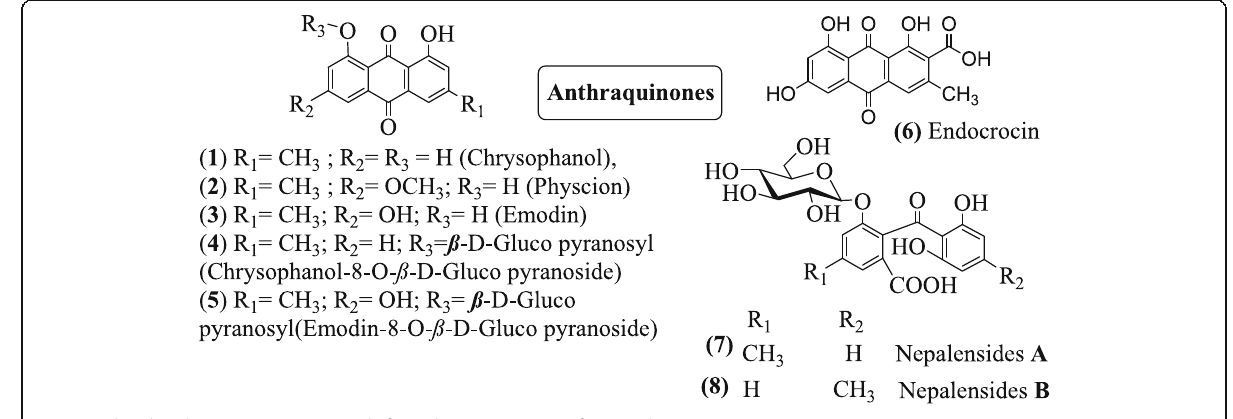
Fig. 2 Isolated anthraquinone compounds from the root extracts of R. nepalensis